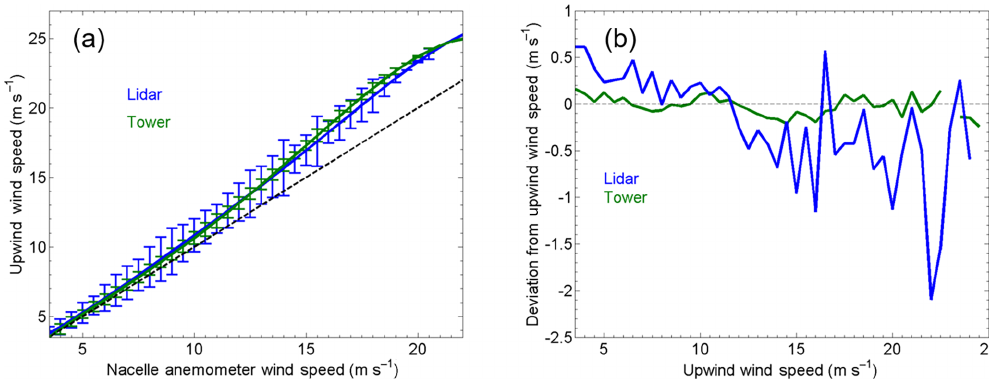
Figure 4. (a) NTFs calculated employing fifth-order polynomial fits using tower hub-height data (green) and lidar hub-height data (blue). Envelopes represent ± σ of the data within the same bins as the bins the NTFs are calculated with. Includes data filtered for tower 80m wind speeds between 3.5 and 25.0ms − 1 , 87m wind directions between 235 and 315 ◦ , and for normal turbine operation. The dashed line is 1 : 1; panel (b) shows the average deviation in NTF-corrected nacelle-mounted anemometer wind speed from tower 80m wind speed (green) and lidar 80m wind speed (blue) versus tower 80m wind speed. The dashed line indicates a 0ms − 1